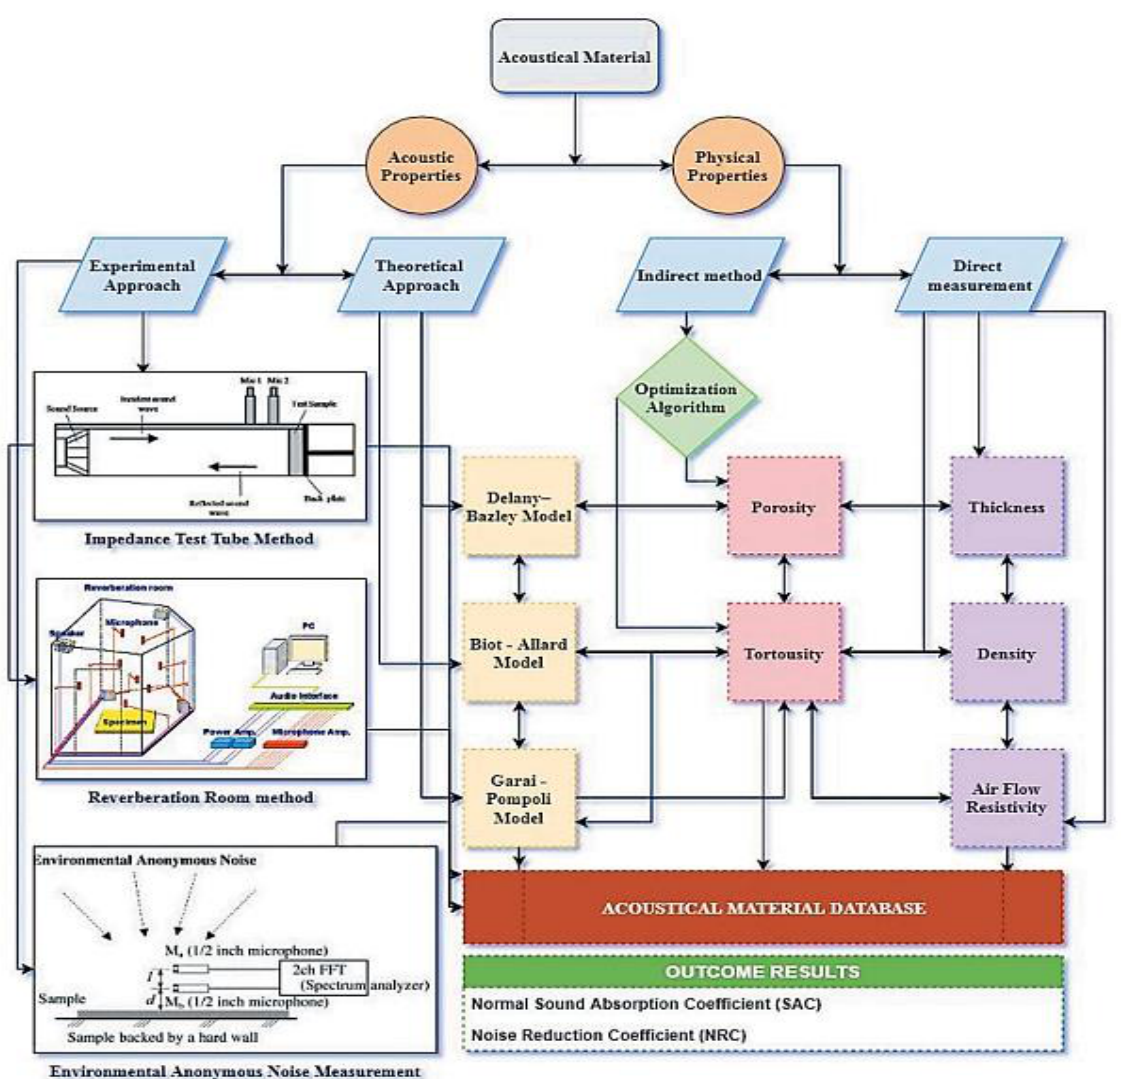
Figure 5. Methods of measuring sound absorption properties (Adapted from the reference [104]).